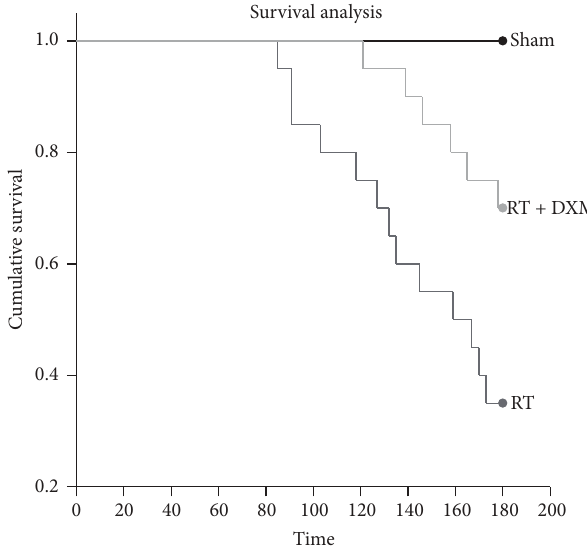
Figure 5: Effect of dexamethasone on the survival of mice after irradiation. C57BL/6J mice were treated with a single dose (15Gy) to the entire thorax. Dexamethasone treatment increased the survival rates of irradiated mice. The survival rates at 180 days in Sham ( 𝑛 = 10 ), RT group ( 𝑛 = 20 ), and RT + DXM group ( 𝑛 = 20 ) are 100.0%,35.0%,and70.0%,respectively(RTversusRT+DXMgroup, 𝑃 = 0.0323 ). The survival rate was analyzed using the Kaplan-Meier